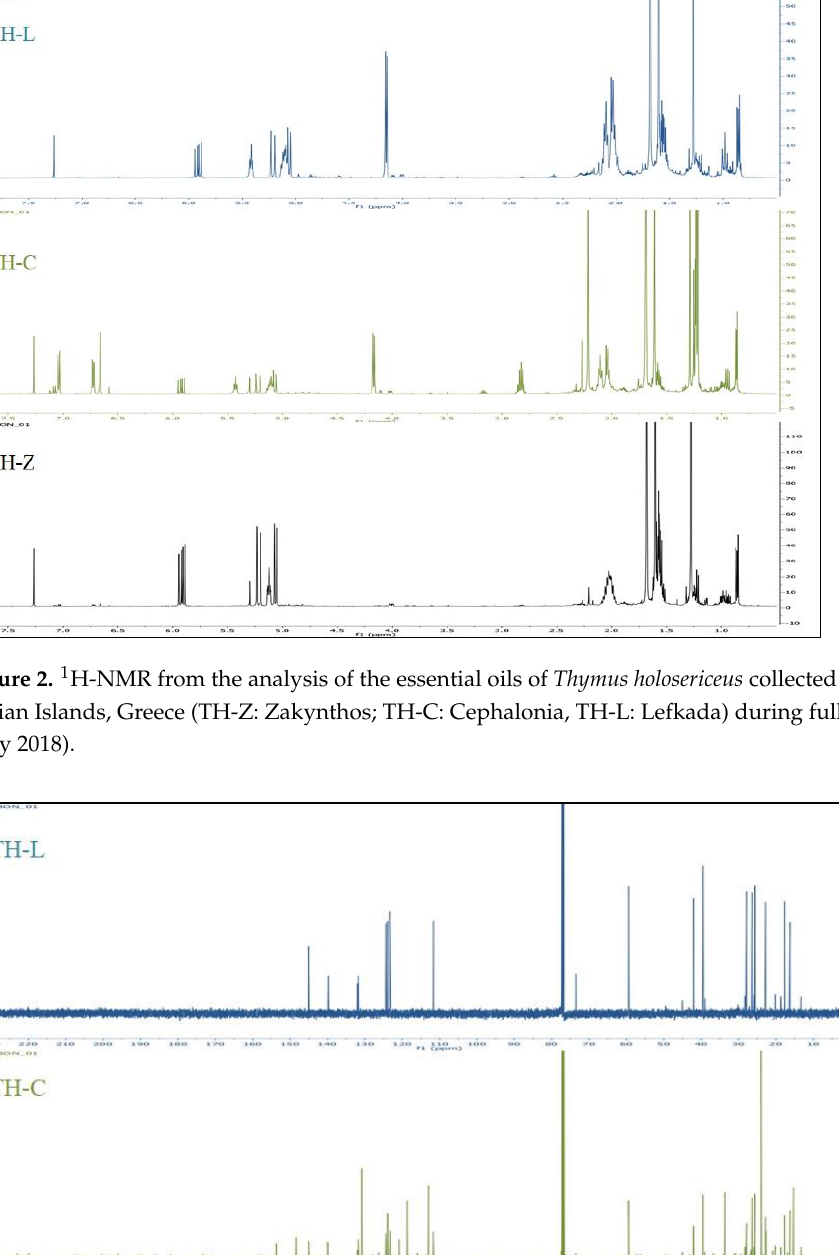
Figure 1. GC-MS chromatographs from the analysis of the essential oils of Thymus holosericeus col- lected from three Ionian Islands, Greece (TH-Z: Zakynthos; TH-C: Cephalonia, TH-L: Lefkada) dur- ing full-flowering (July 2018).